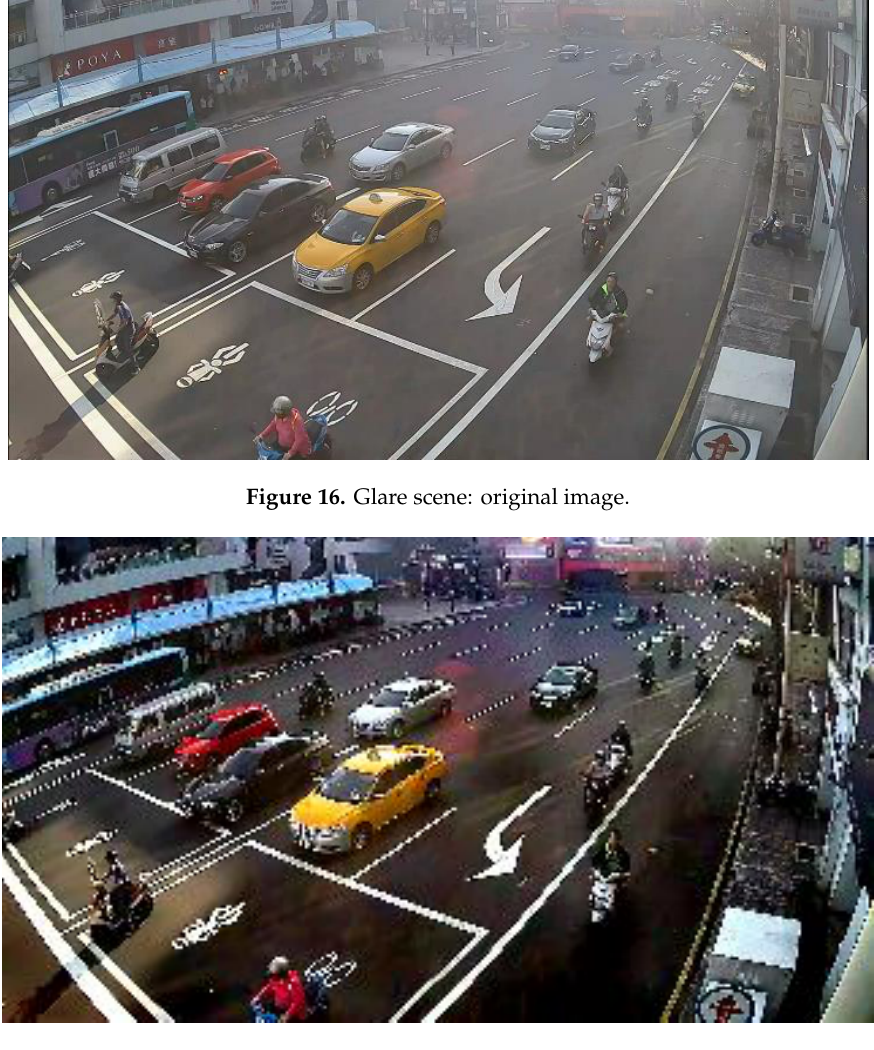
Figure 18. Haze scene: original image.